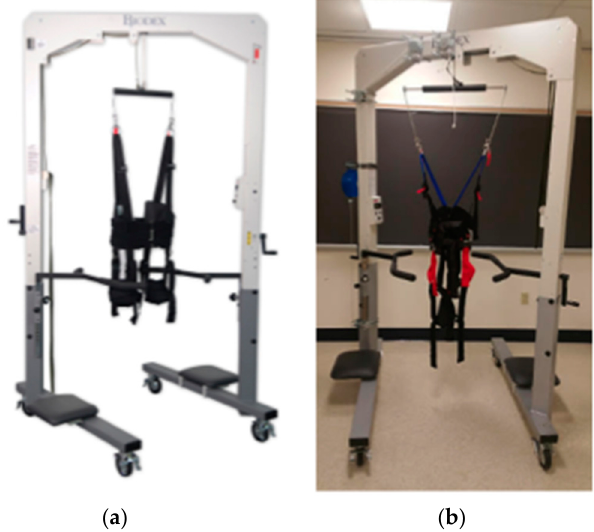
Figure 9. ( a ) Unmodified Biodex system (Photo courtesy of Biodex Medical Systems, Inc. [14]); ( b ) modified Biodex system with extended bar attached to the harness, the counterbalance to the left and the four pulleys.